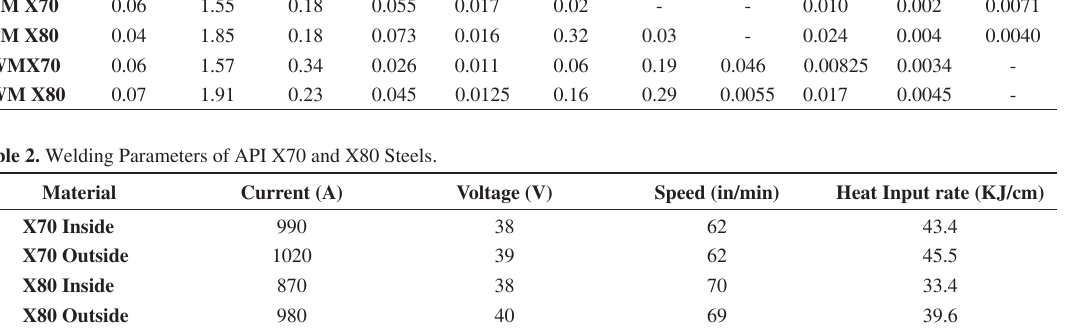
Table 1. Chemical compositions of the base metal (BM) and weld metal (WM) in wt%. Material